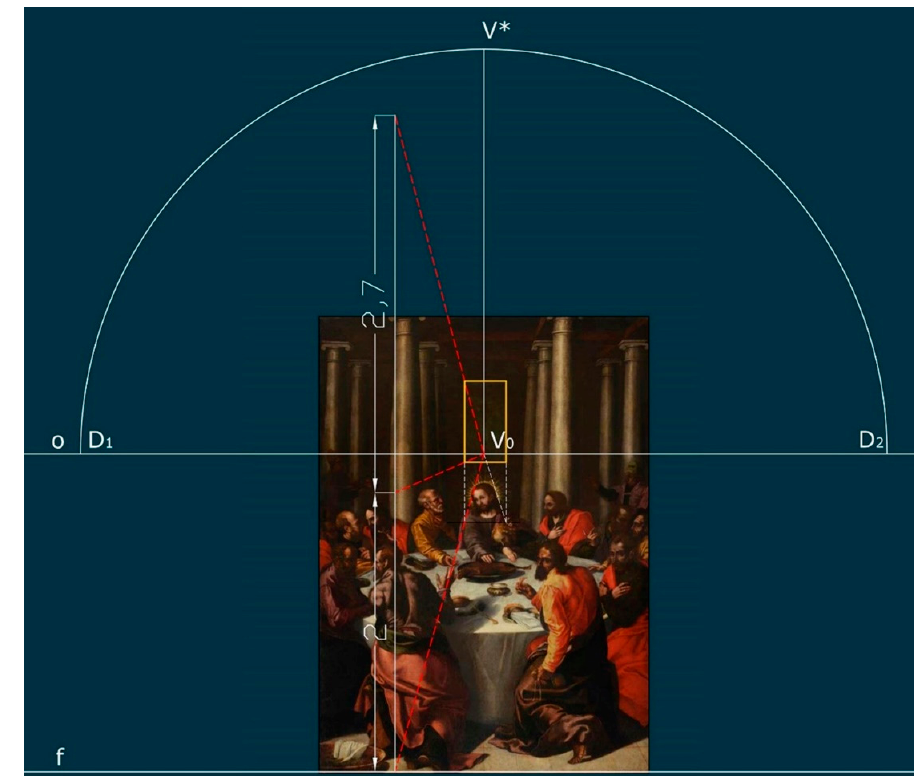
Figure 19. Dimensioning of the opening with the perspective restitution.